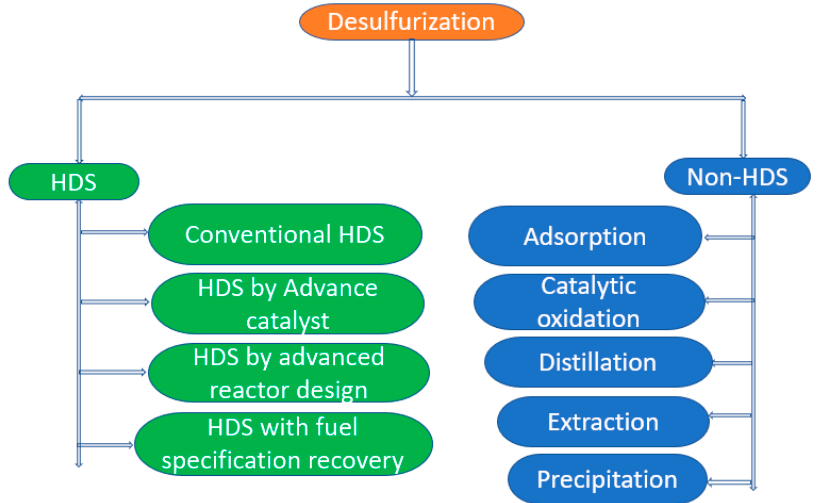
Figure 2. Classification of desulfurization technologies to remove sulfur from liquid fuel oil